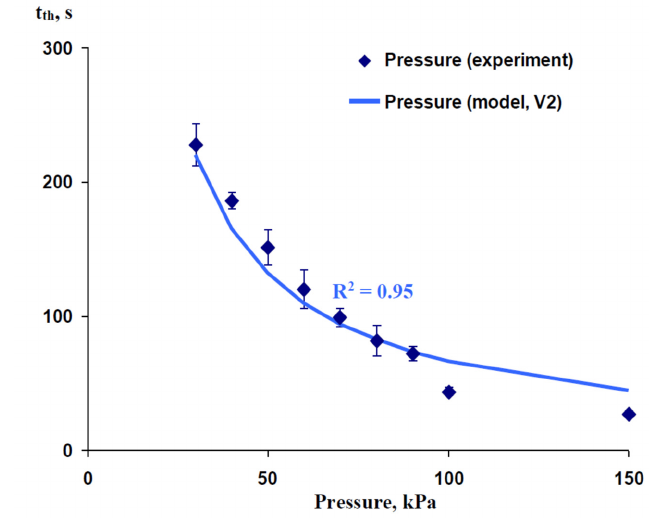
Figure 4. Experimental and simulated dependence of the time of initiation of variation potential (t th ) on the pressure dynamics acting on the tip of the stem of pea seedlings. The experimental t th is calculated (means and standard errors) on the basis of the results that were presented in [44]; only a 60 mm distance from the zone of pressure action is analyzed. Only Variant 2 (V2) of the model was used in this analysis (see Figure 1b). It is assumed that V2 (constant increased pressure for all time of response) is in accordance with the artificial action of the increased pressure in [44]. The length of the xylem vessel (L) is assumed as 120 mm (on the basis of [44]). The duration of pressure increase (t R ) is assumed as 1000 s because this duration was more than any experimental t th and is in accordance with the artificial long-term increase in pressure. The ratio of the P’ integral, which is necessary for variation potential induction, to the total P 0 ’ integral in the zone of damage (N) is assumed as 0.11 for 30 kPa (N 30 ). Under other values of current pressure, we used N, which were calculated as N 30 30 because the total integral of pressure in the zone of damage was proportional to the current pressure. R 2 is the determination